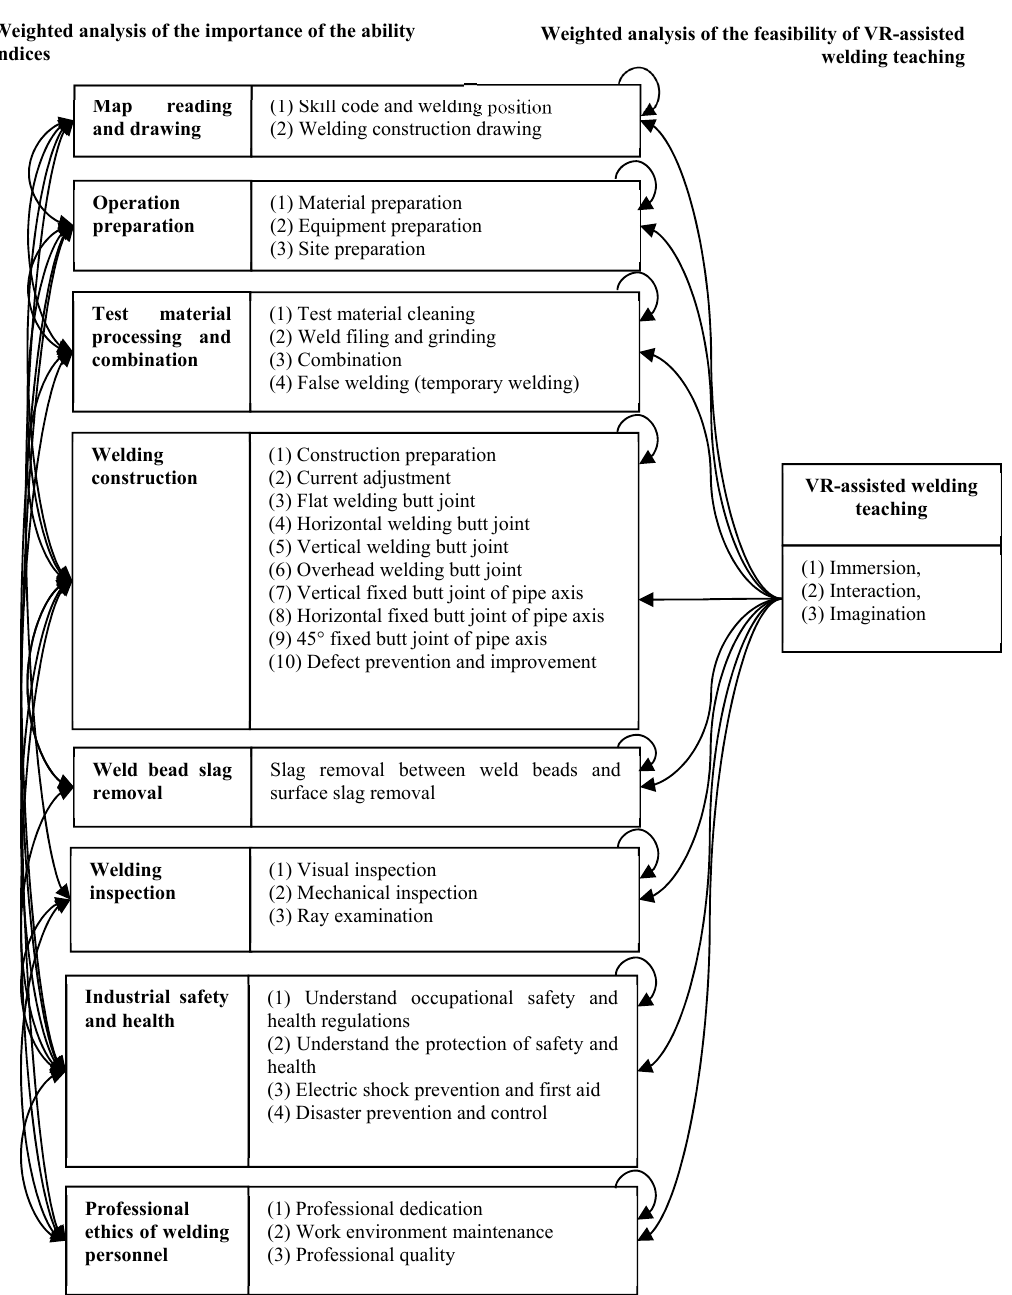
Figure 3. ANP Framework of VR-Assisted Welding Course Teaching.